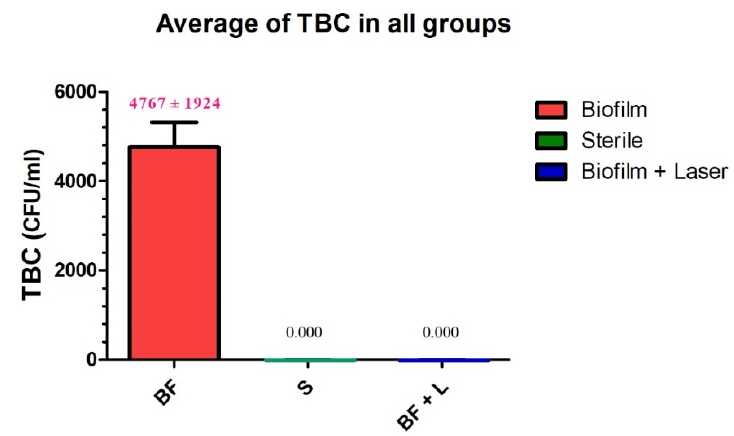
Figure 6. Results of the microbiological assessment in the three